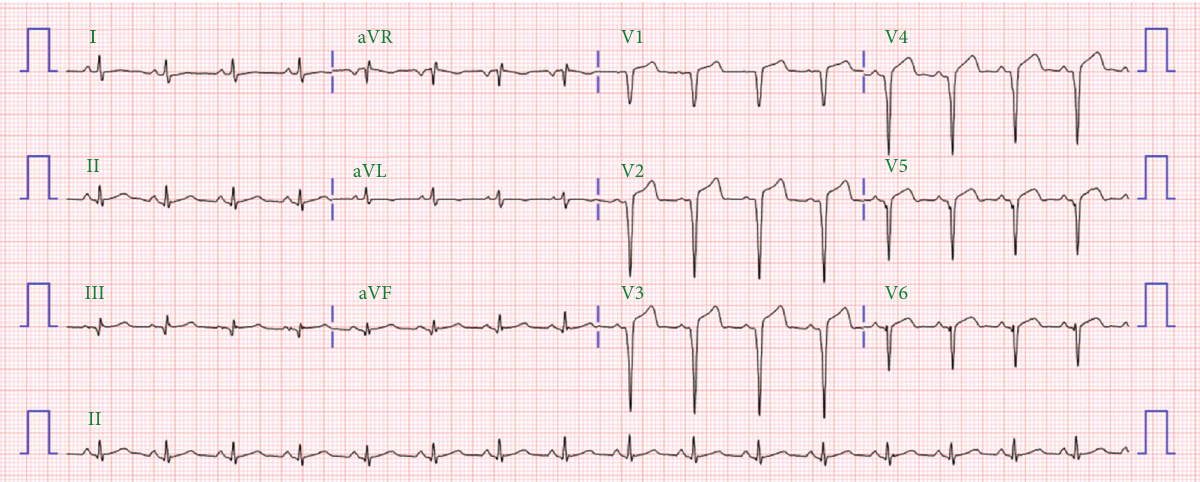
Figure 5: Repeat ECG following discontinuation of ticagrelor. There is shortening of the previously prolonged QT interval. ECG two days after ticagrelor discontinuation. No further cardiac events are sustained in the follow-up period. ECG: